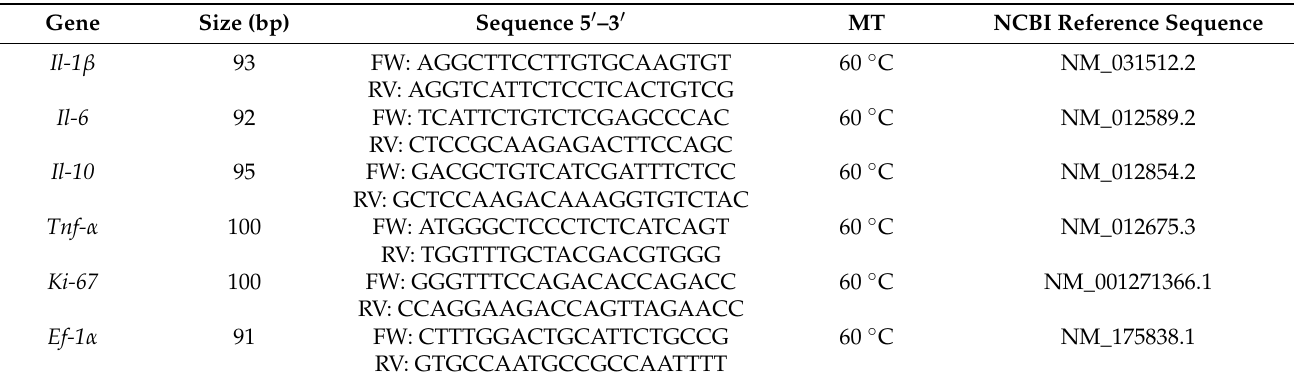
Table 1. Specifications of primers used in